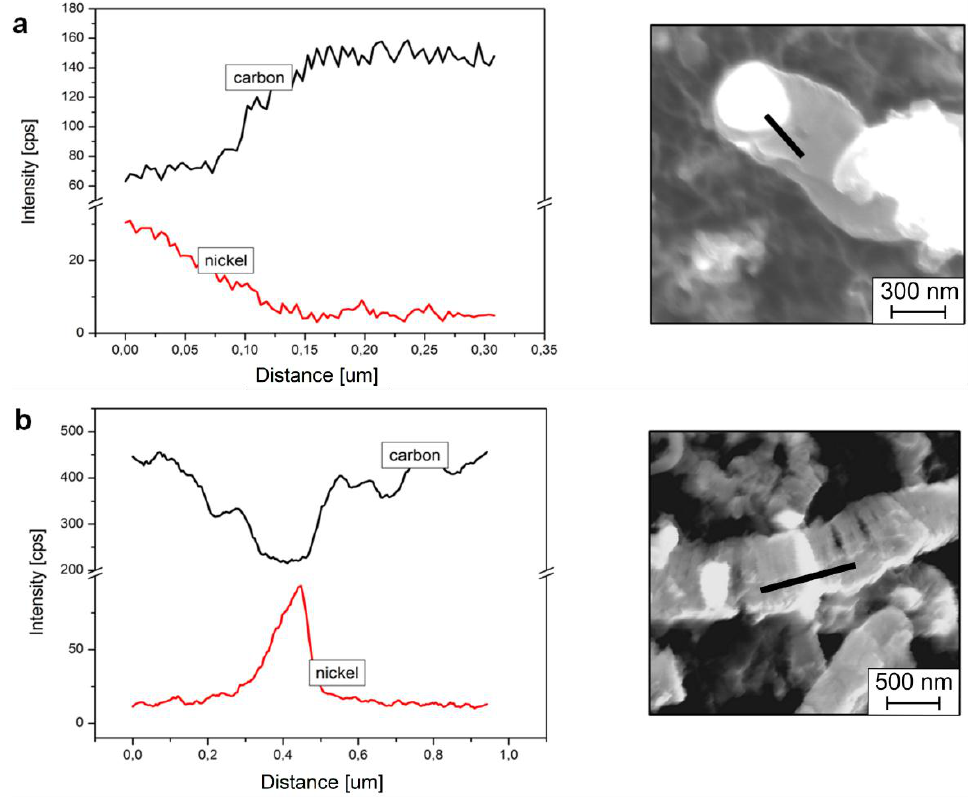
Figure 5. The energy dispersive spectrometry (EDS) linear analysis along the nanofiber with nickel-like nanoparticles in ( a ) tubular and ( b ) platelet